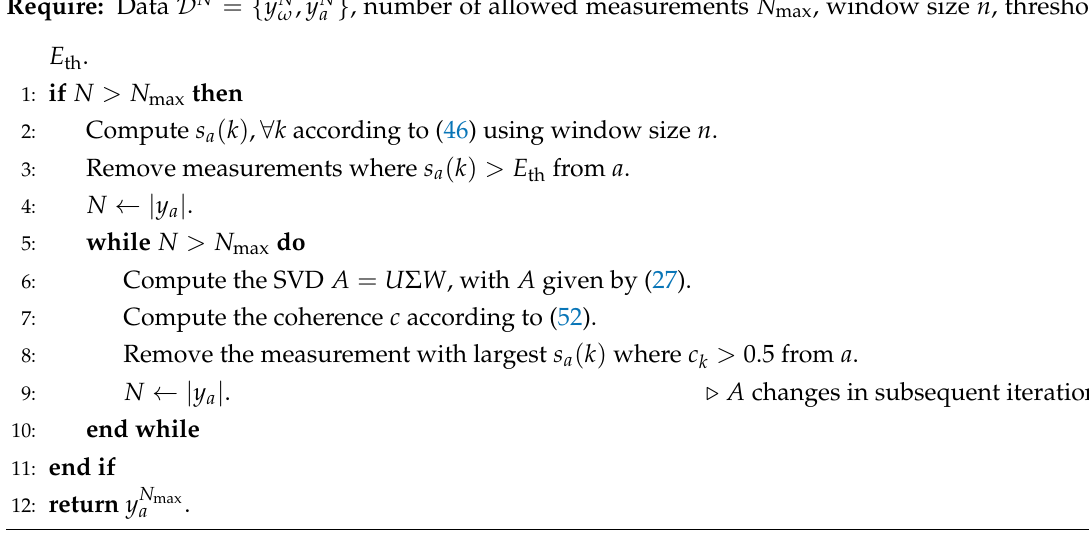
Algorithm 3 Accelerometer sample